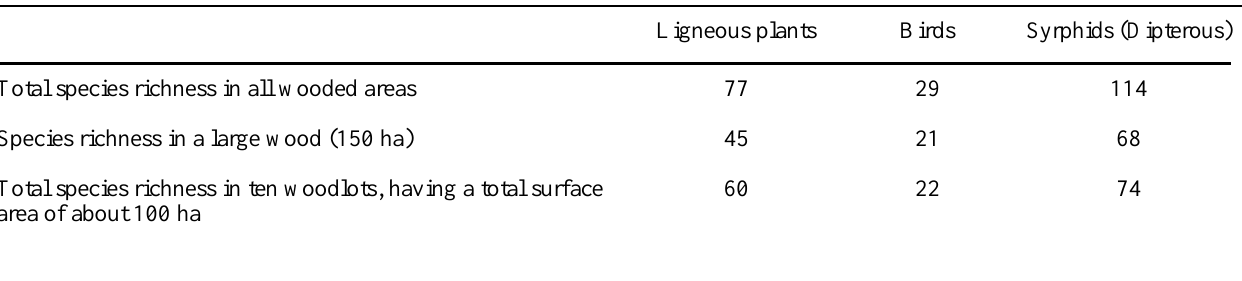
Ligneous plants